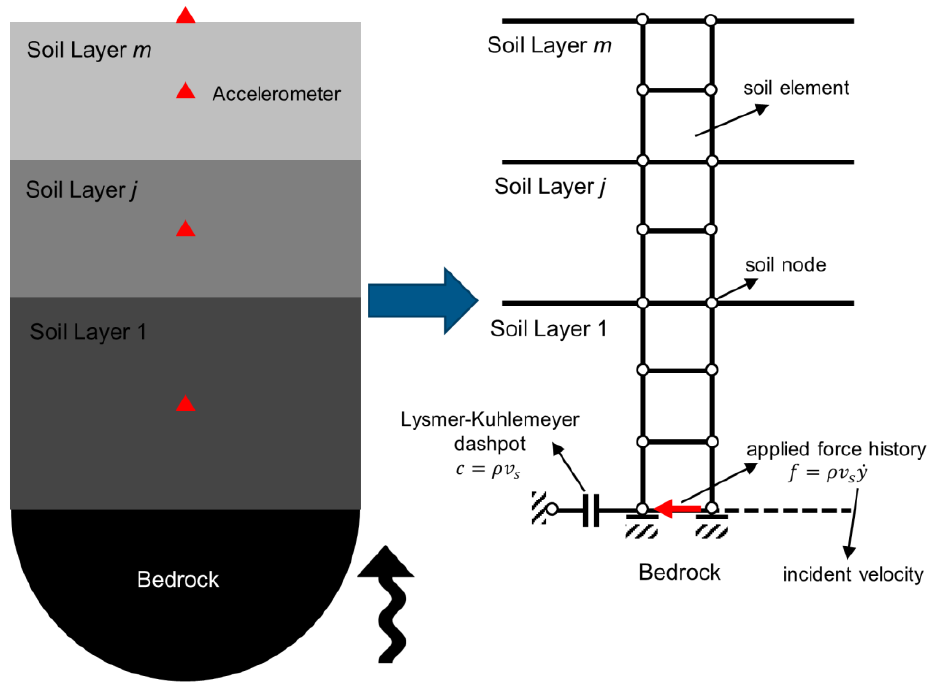
Figure 4. The generic site ( left ) and its finite element model ( right ).